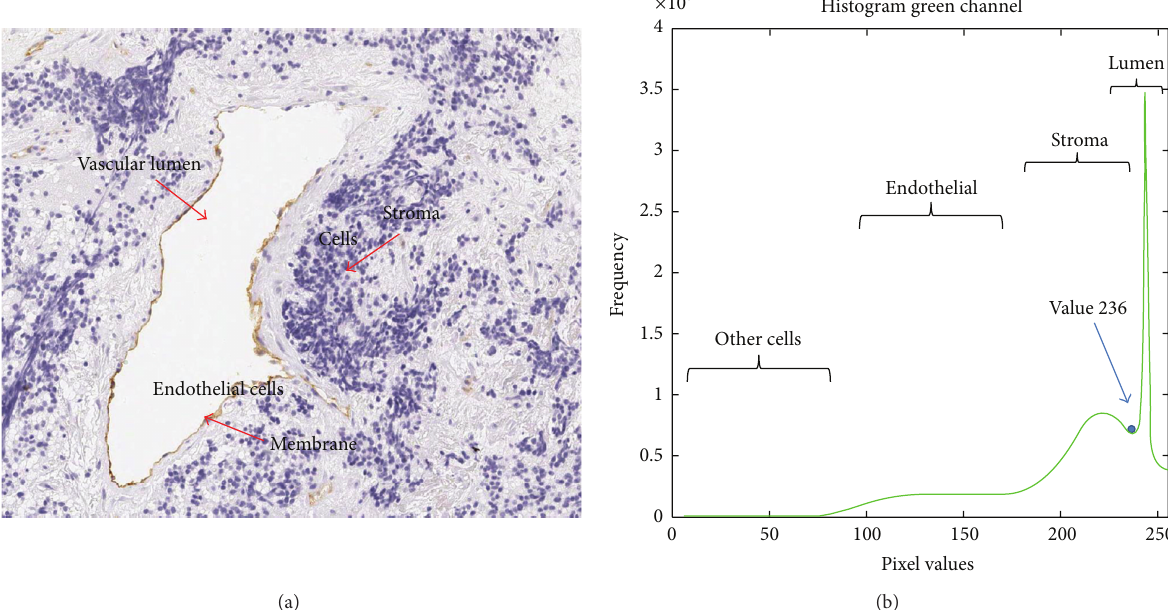
Figure 3: Statistical analysis of the TMA structures based on the image histogram. (a) Original TMA sample with the main structures, (b) histogram of the green channel